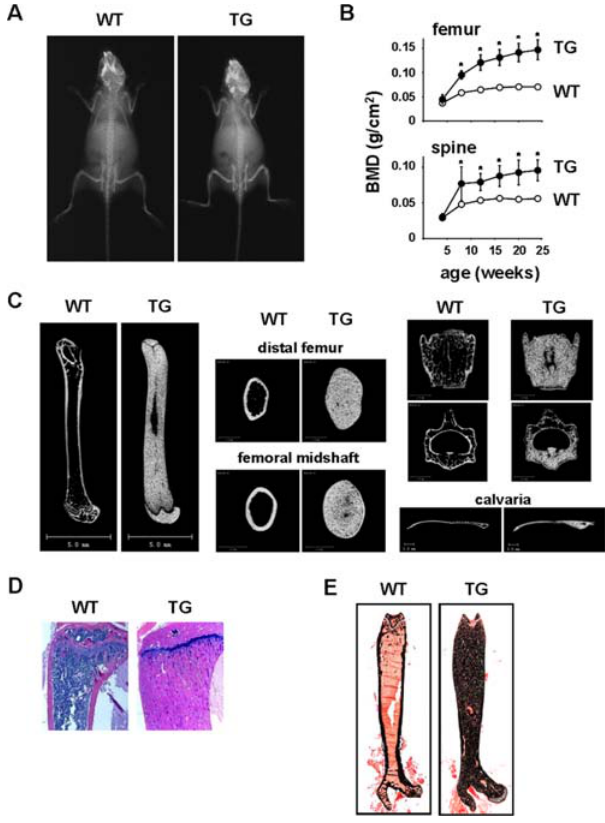
Figure 2. DMP1-caPTHR1 Mice Exhibit High Bone Mass. (A) Radiographs of 4-week-old female wild type (WT) and DMP1-caPTHR1 transgenic (TG) mice. (B) Femoral and spinal BMD in WT and TG female mice, measured at 4 wk intervals up to 24 wks of age. Symbols represent the mean 6 SD of 5 mice. * p , 0.05 vs. WT mice at each time point. (C) Representative longitudinal and cross-sectional micro-CT images of femur, 4th lumbar vertebra, and calvaria obtained from 10.5- week-old female WT and TG mice. (D) Hematoxylin and eosin staining of tibial and (E) von Kossa staining of femoral bone sections from 10.5- week-old WT and TG mice.